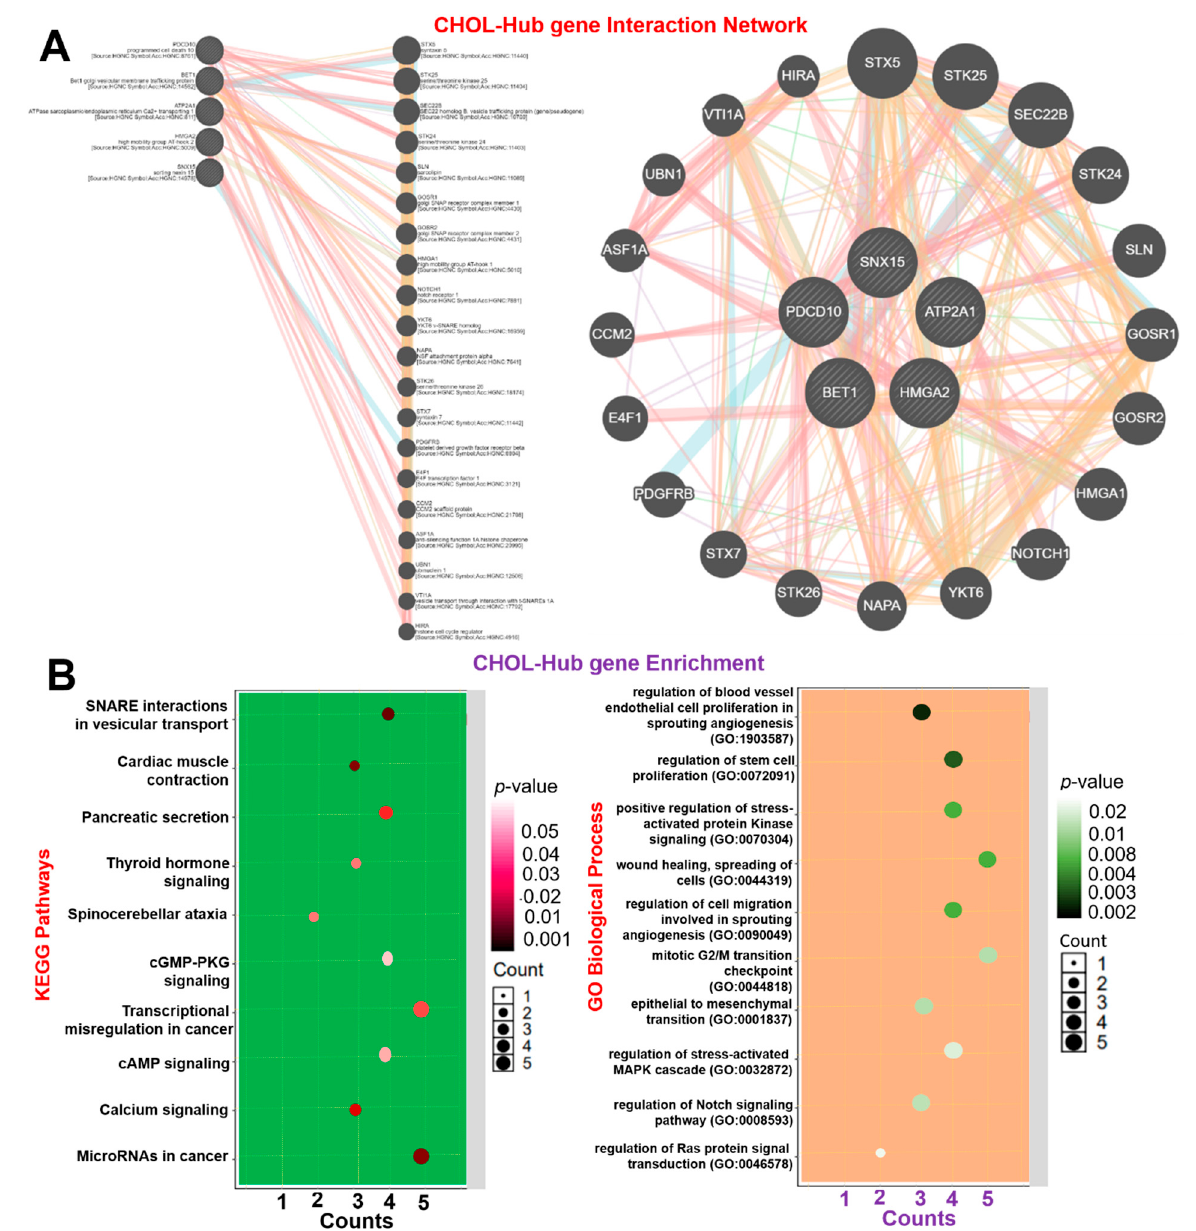
Figure 4. Gene interaction and enrichment analysis of cholangiocarcinoma (CHOL)-hub genes and ( A ) gene-gene interaction (GGI) network. ( B ) Enrichment of KEGG pathways (left panel) and GO biological processes (right panel) of hub genes.